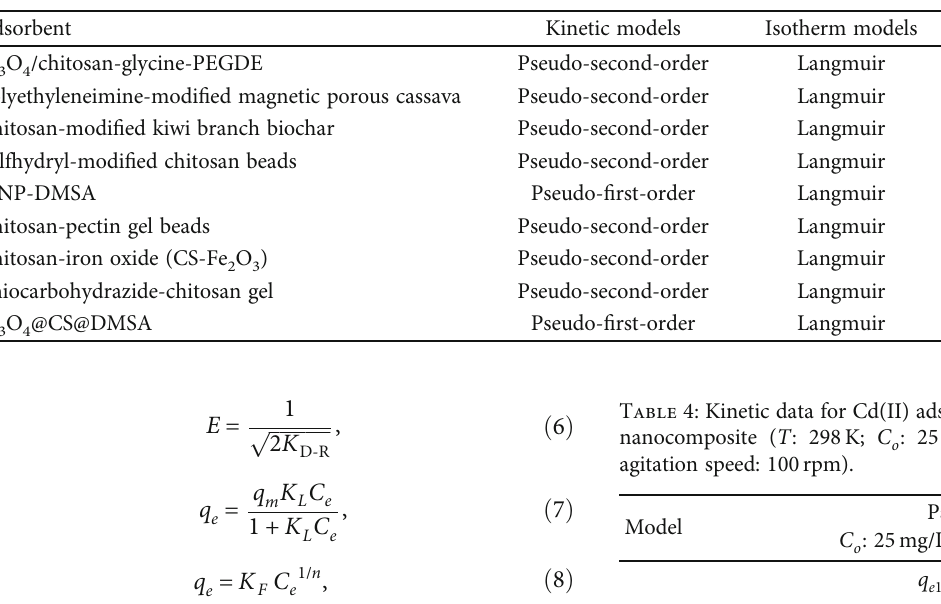
O @CS@DMSA nanocomposite with di ff erent adsorbents. 3 4